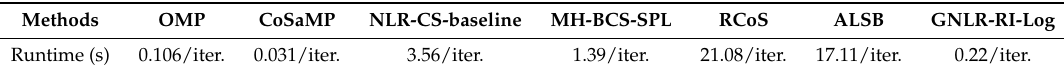
Table 7. Reconstruction time for a 256 × 256 single-channel